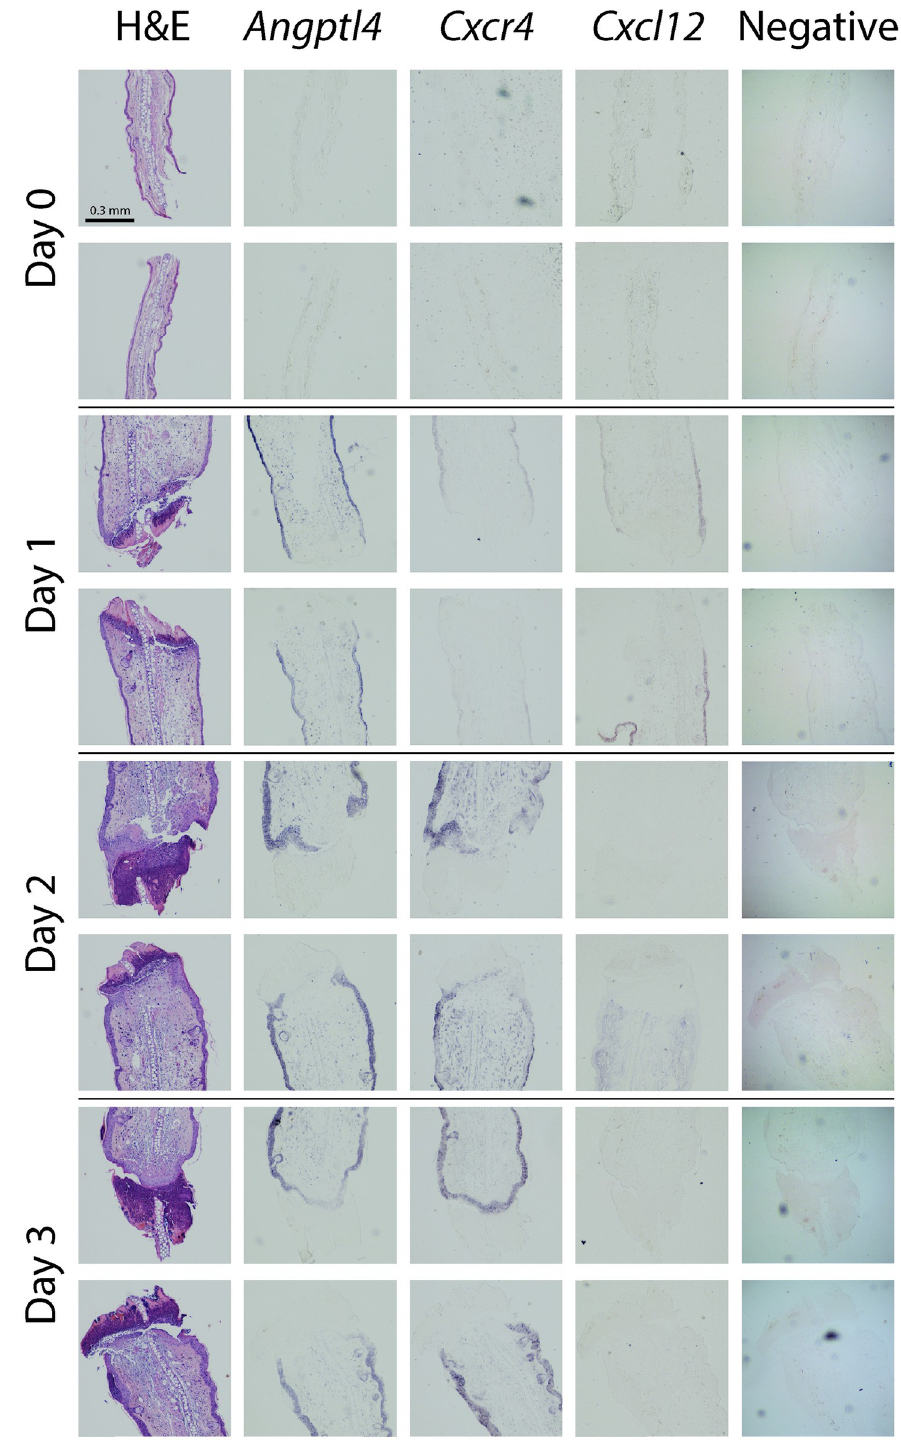
Fig 2. Histology of the ear wound and detection of Angptl4 , Cxcr4 , and Cxcl12 mRNA . Hematoxylin and eosin staining (H&E) and detection of Angptl4 , Cxcr4 , and Cxcl12 RNA hybridization in sequential cross-sections through ear wounds at 0, 1, 2, and 3 days after wounding. All images were taken at 10x magnification. First column: H&E stains of both sides of the ear wound. Second-fourth columns: corresponding in situ hybridization staining of Angptl4 , Cxcr4 , and Cxcl12 , respectively. Scale bars (0.3mm) are indicated on top-left panel only, however the scale is uniform throughout all panels. Images are representative of n = 3.